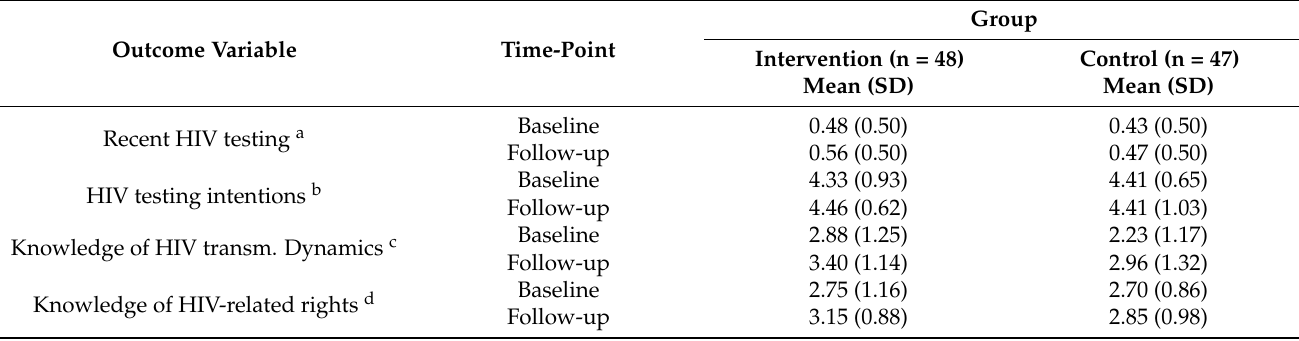
Table 5. Means and standard deviations (SD) of HIV-related outcomes by group (intervention vs. control) and time-point (baseline vs.